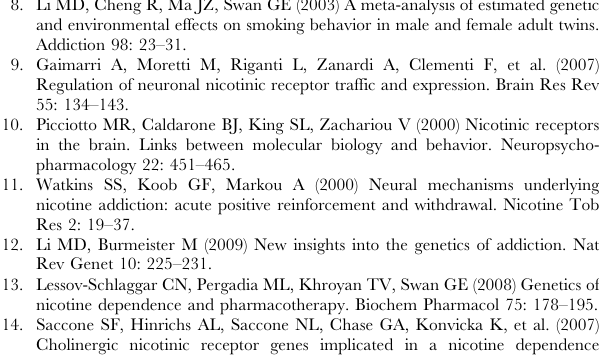
Table S1 Positions, nucleotide variations, and allele frequencies for SNPs on chromosome